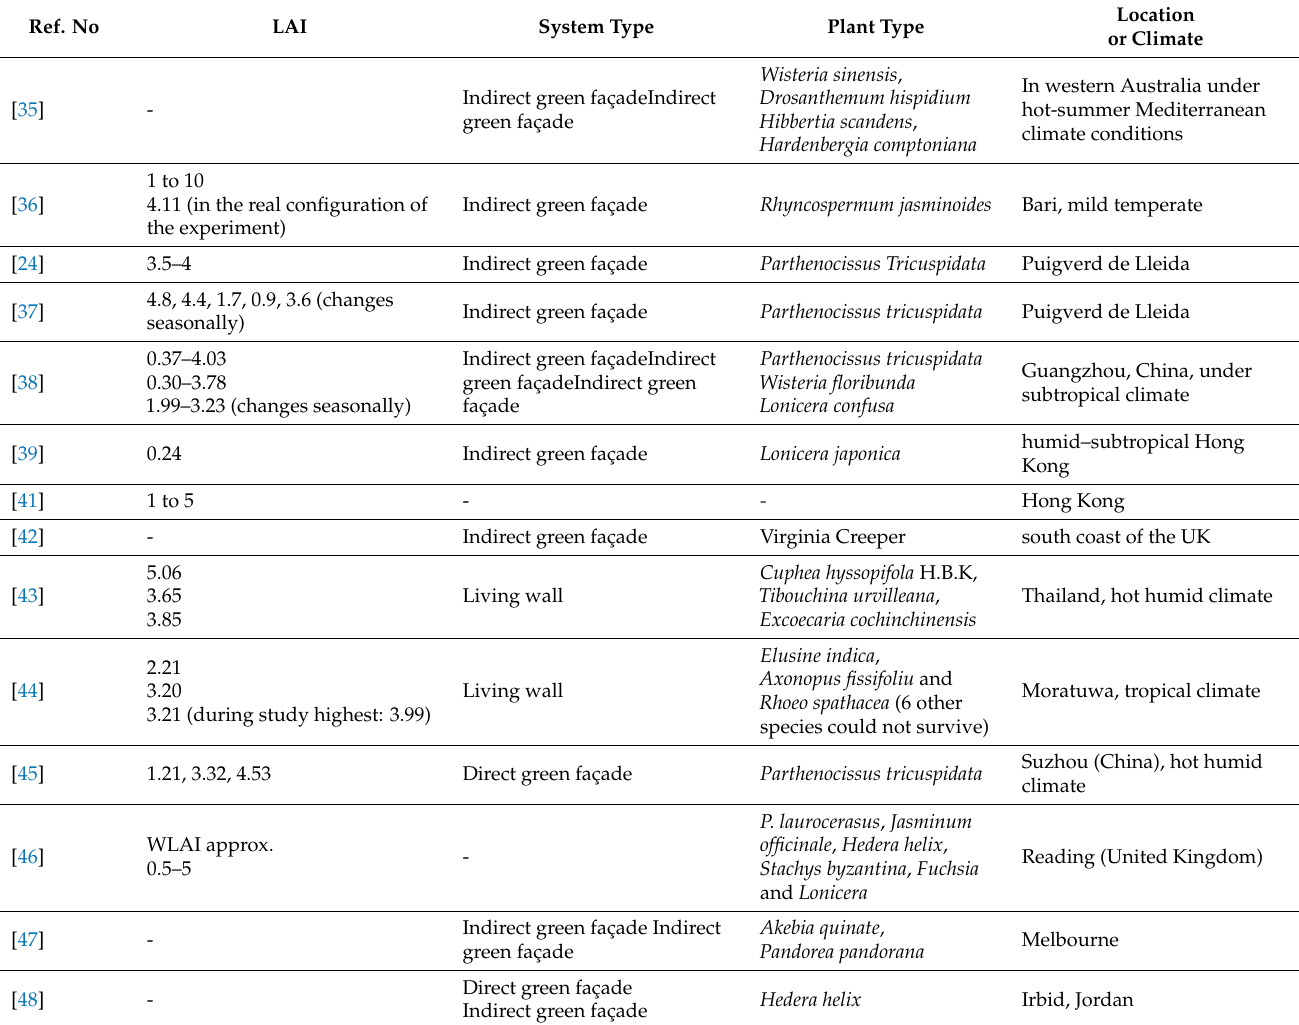
Table 3. Plant species and characteristics in the reviewed